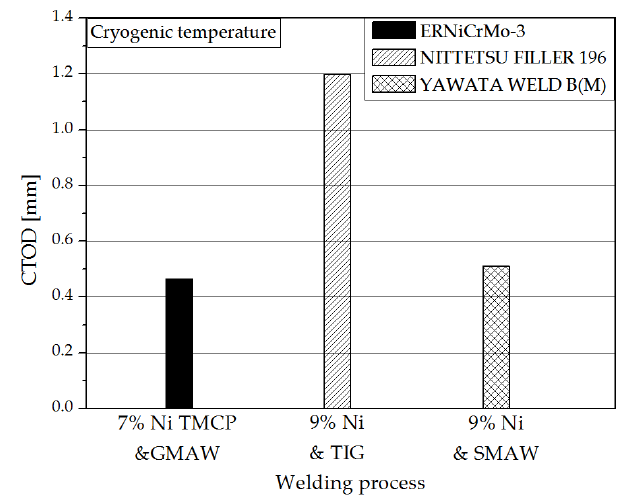
Figure 11. CTOD values of the weldment for 9% nickel steel and 7% TMCP nickel steel [5].